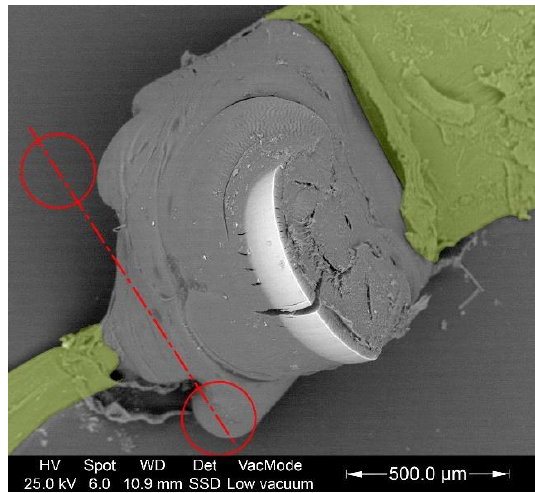
Figure 7. Electron micrograph of the right mandible. The tendons are highlighted in green and the joints and axis of rotation are highlighted in red.